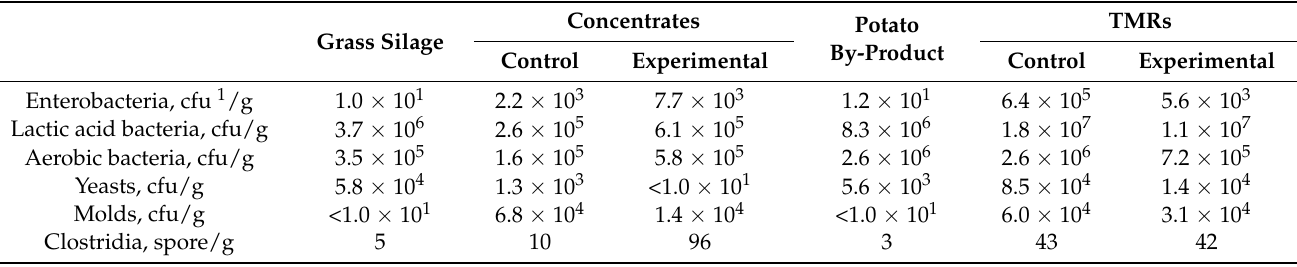
Table 3. Microbial quality of feeds and total mixed rations (TMR) used in the dairy cow feeding experiment (Experiment 1). TMRs Concentrates Potato Grass Silage By-Product Control Experimental Control Experimental